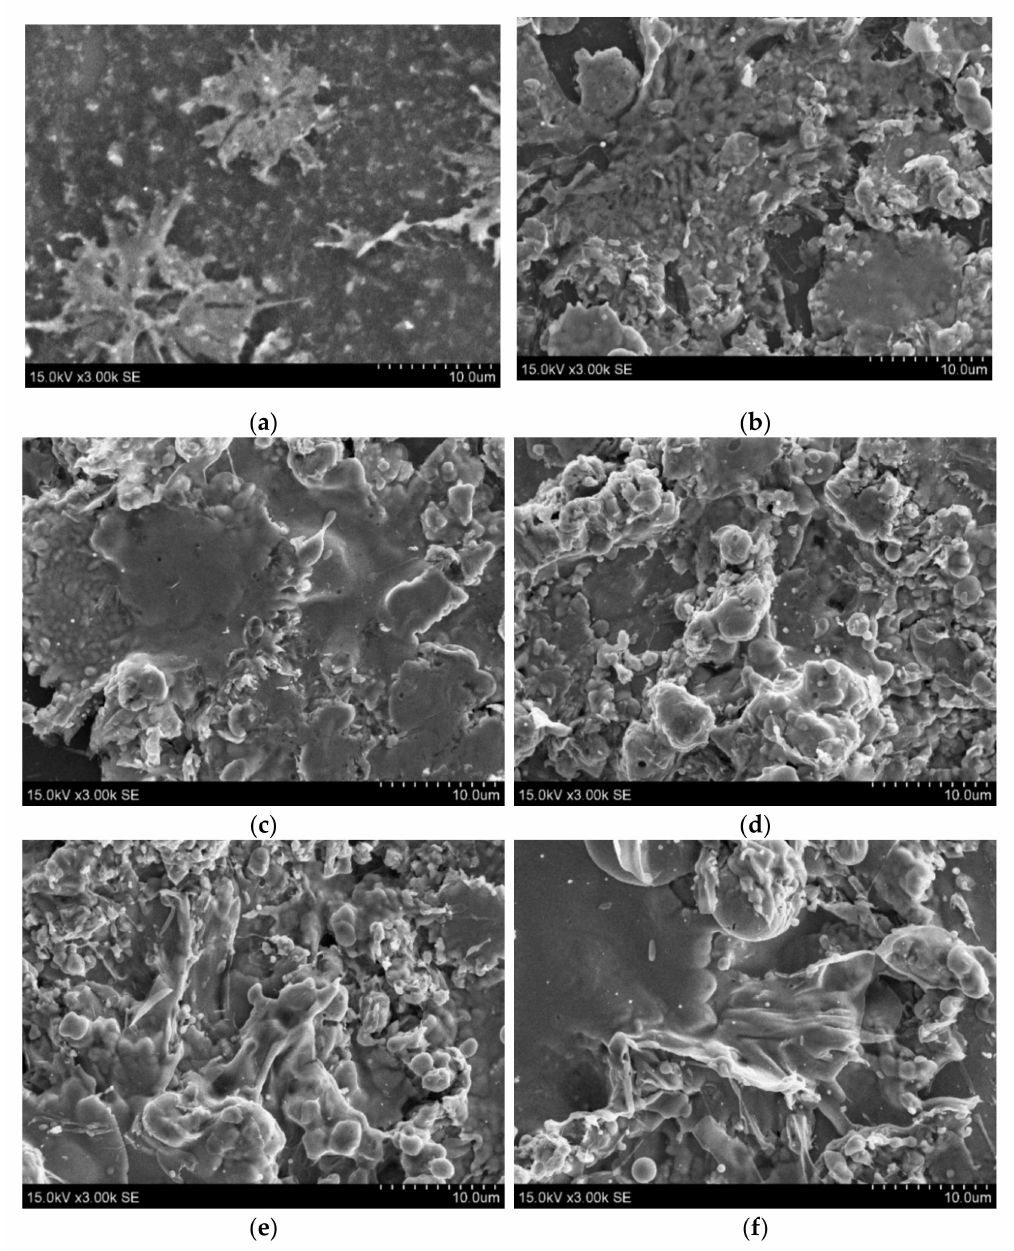
Figure 1. Surface morphology of ( a ) graphite, ( b ) Gr-10Cu, ( c ) Gr-20Cu, ( d ) Gr-40Cu, ( e ) Gr-60Cu, and ( f ) copper films deposited using plasma